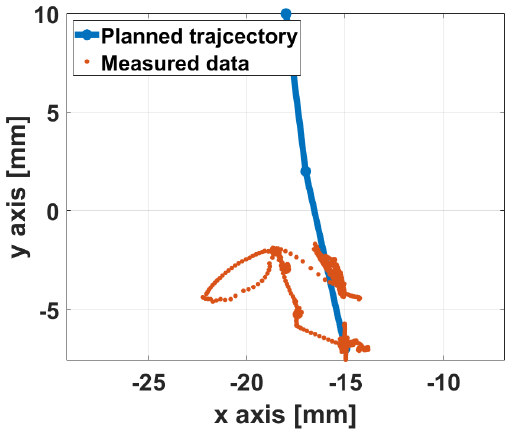
Figure 24. Comparison the planning trajectory and measurement data in the AA